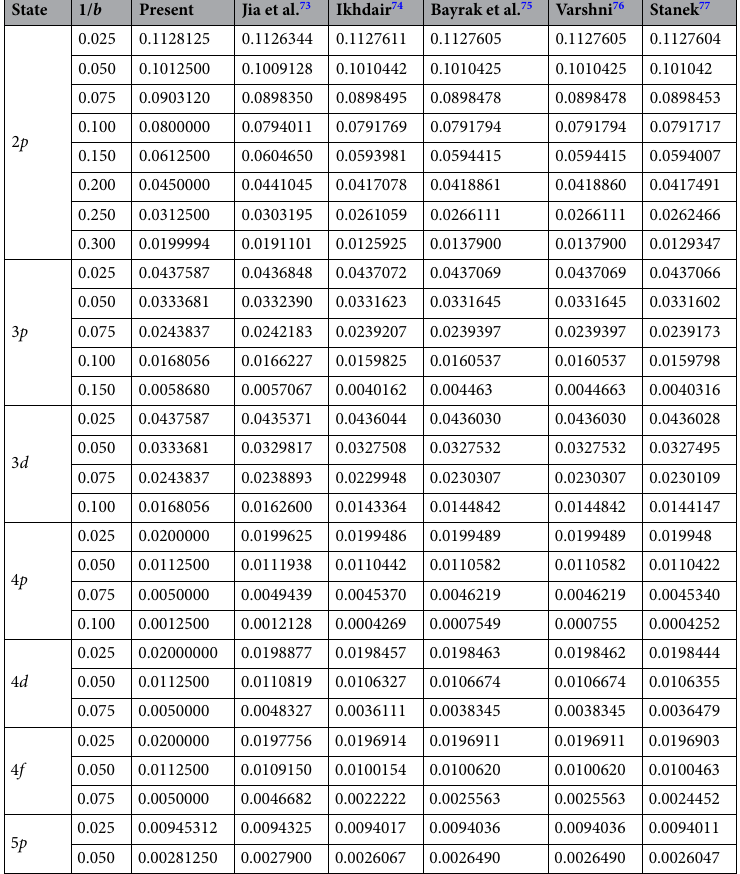
Table 10. Comparison of energy spectra (